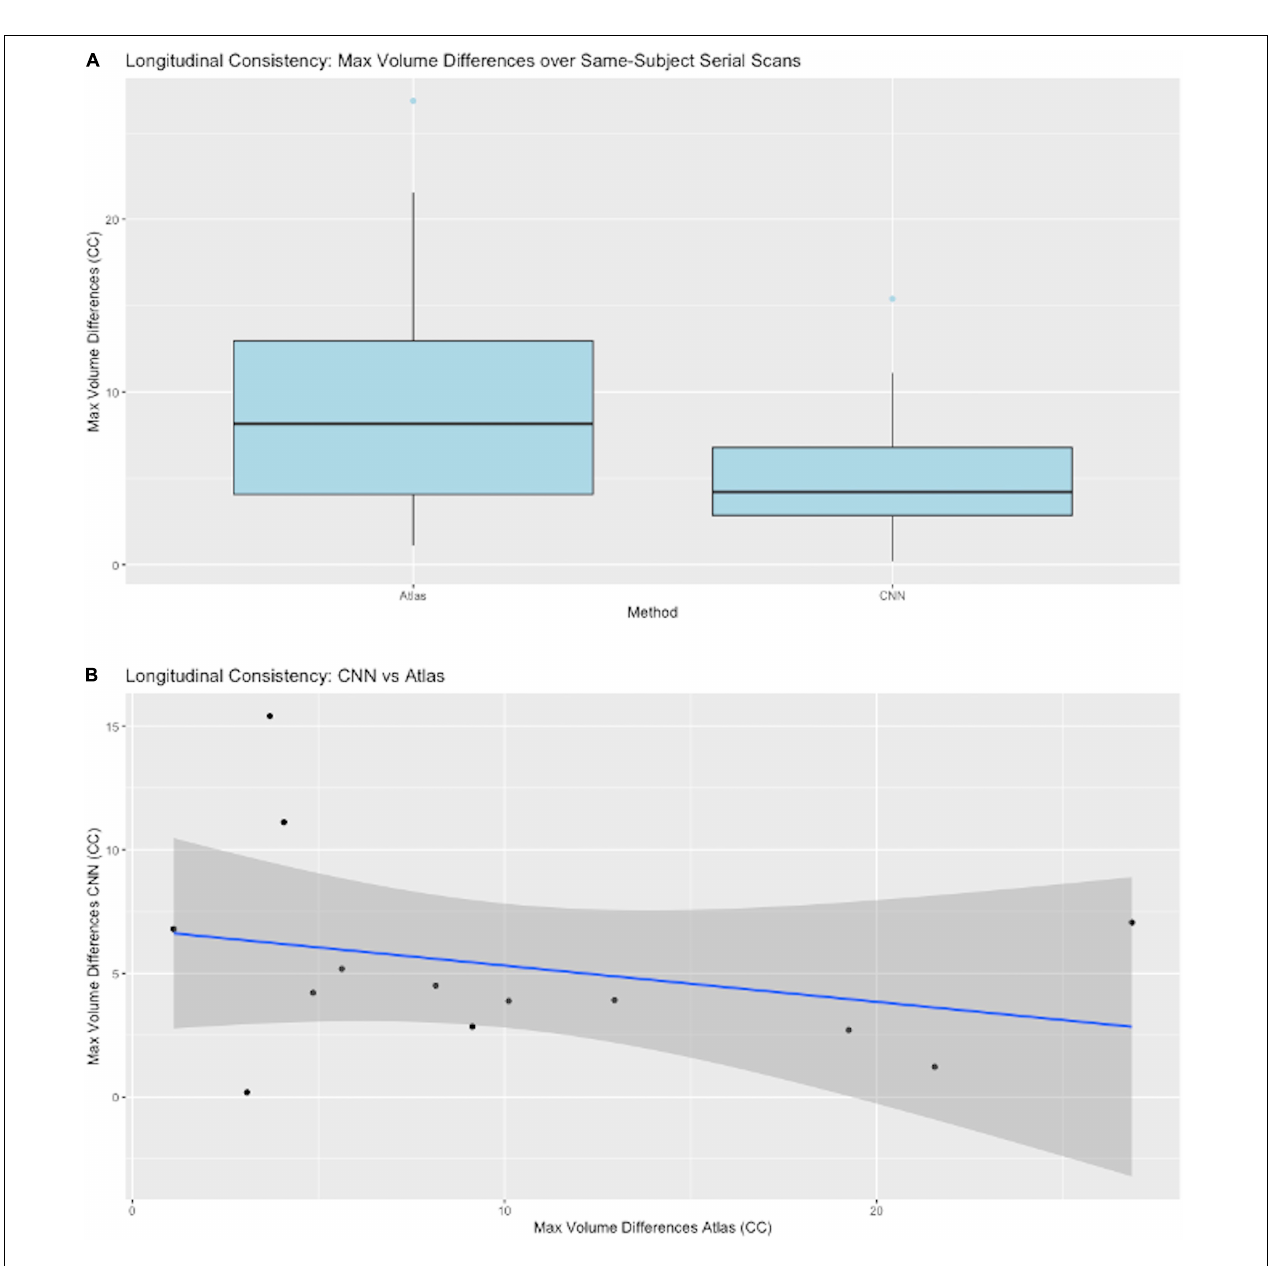
FIGURE 7 | CNN model performance on same-subject repeated scans. (A) Distributions of maximum volume differences in estimated same-subject ICC masks. Left entry: the max volume differences for ground truth sets using atlas-based masks. Right: the same performance metric for CNN prediction masks. (B) Plots of CNN vs. atlas estimated max differences by subject. The straight line is a regression fit of the plots, suggesting that average CNN-predicted differences are roughly constant while corresponding atlas-based predictions vary over a large range.